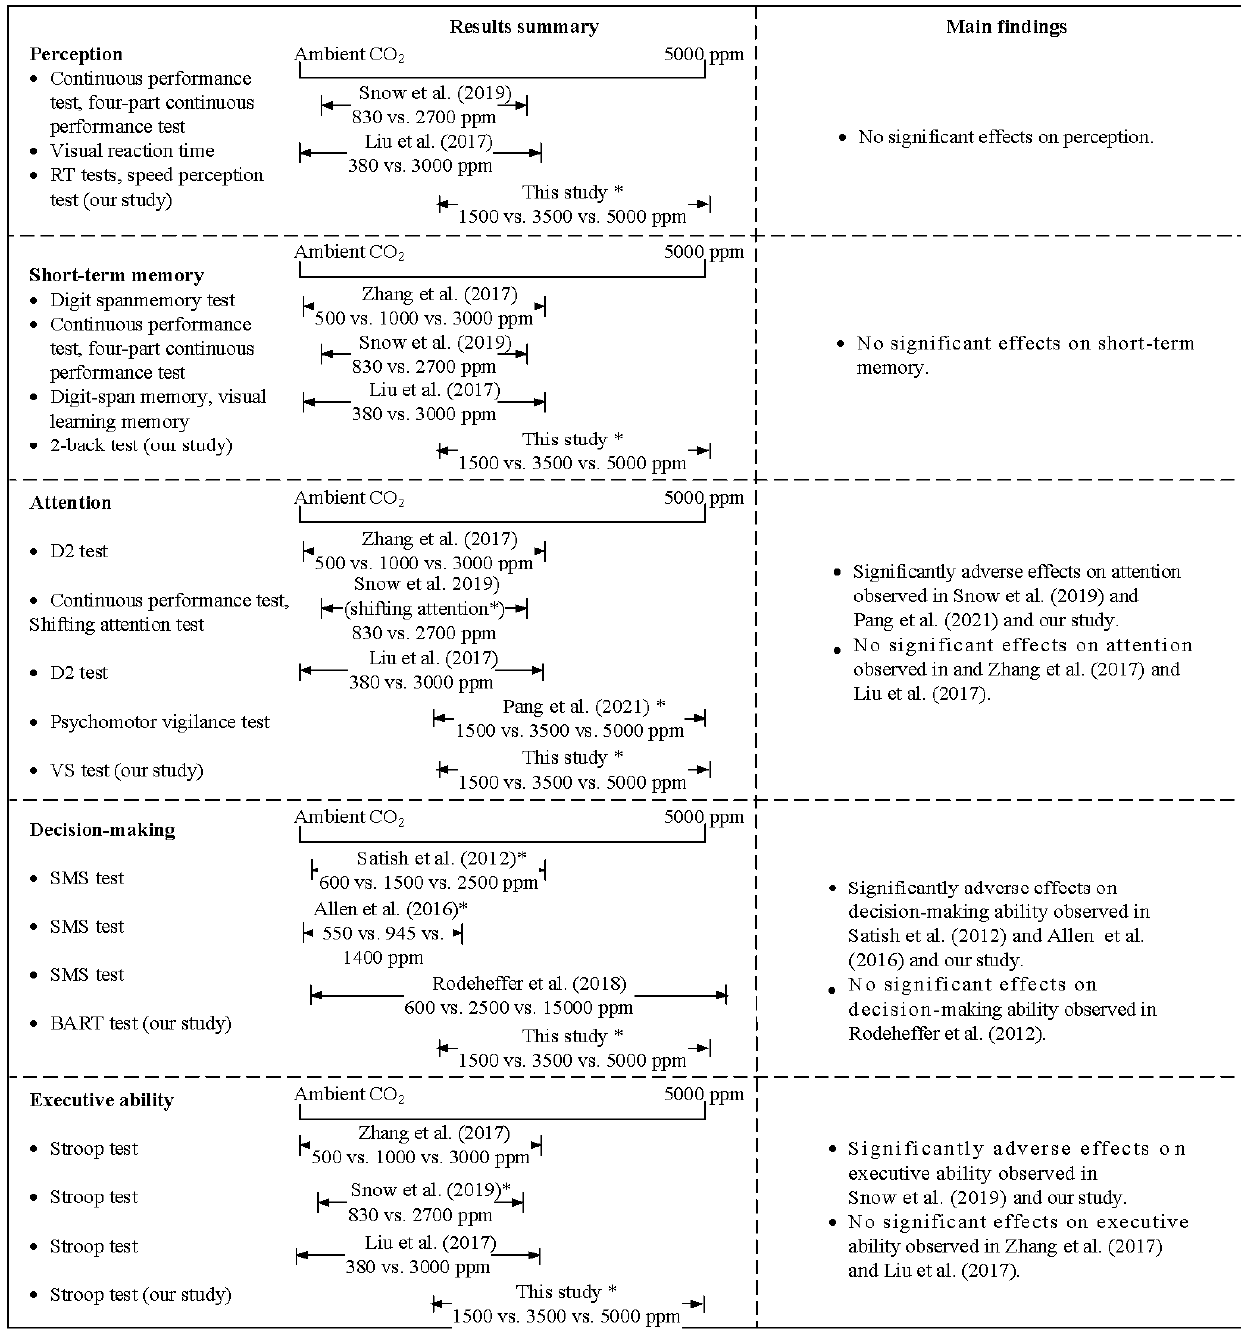
Figure 8. Results summary of additional pure CO 2 effects on the five cognitive abilities. * Studies with statistically significant ( p < 0.05) changes in performance